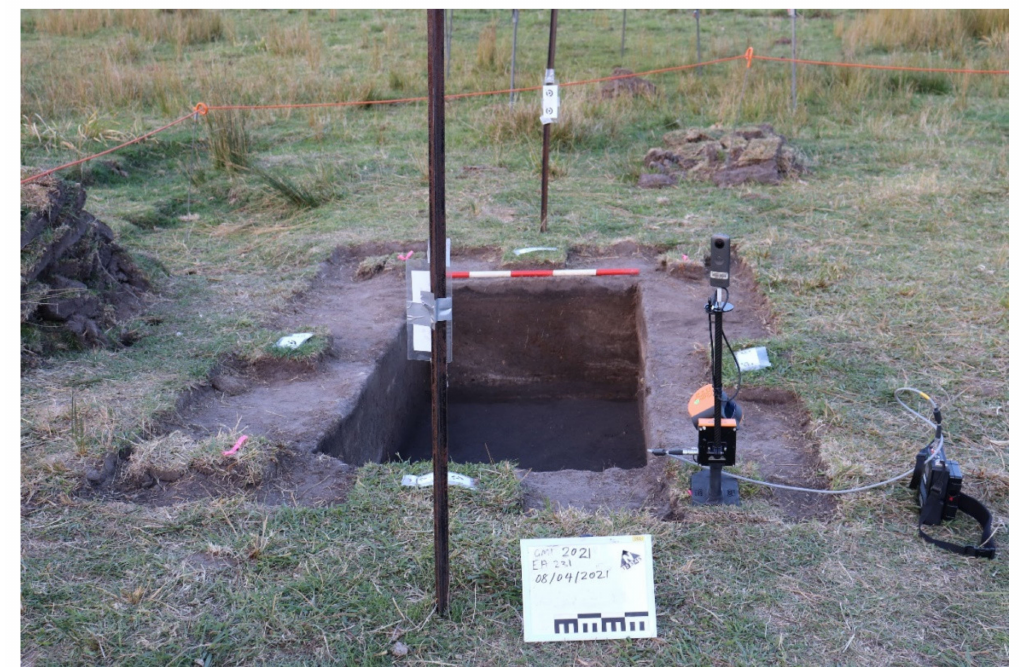
Figure 3. EA231 at the point of recording layer 6. An extra ca. 25 cm has been de-turfed to create a stable edge to the trench. PG targets are around the trench and on the Y fence posts. The GeoSLAM Zeb Horizon is located on one of the base points, with the others marked by pink flagging